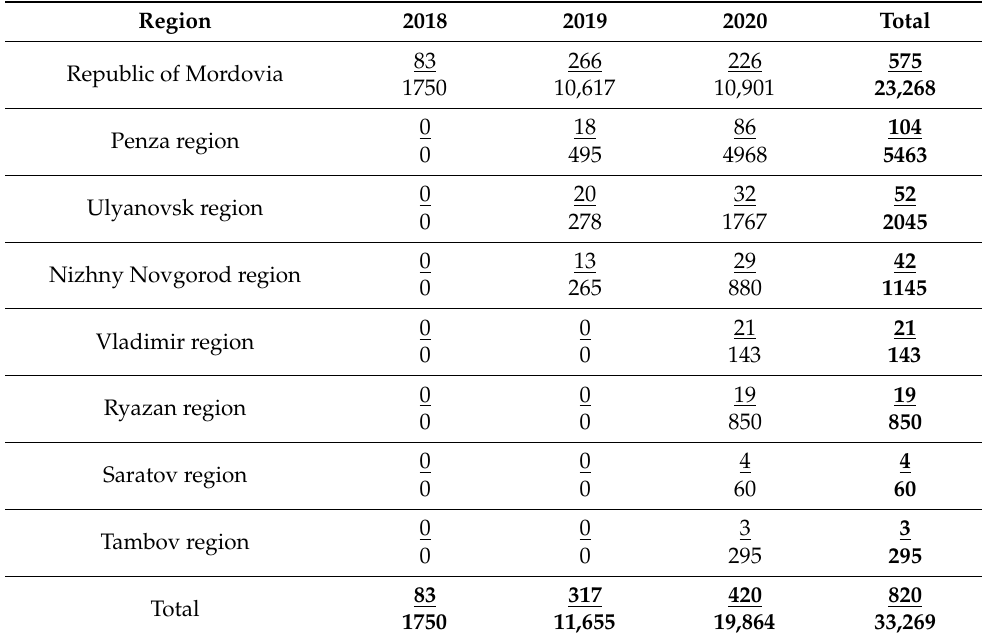
Table 1. The quantity of the collected material in the regions of Russia *.